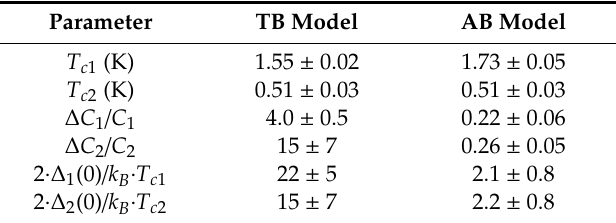
Table 6. Deduced parameters for for Nb / Bi 2 Se 3 / Nb junction [57] from fit to two-band Titov